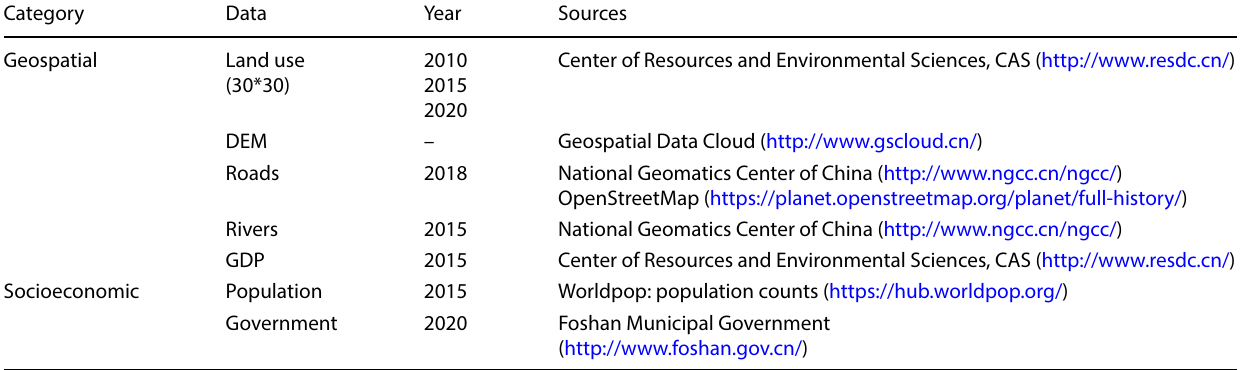
Table 1 Data sources and